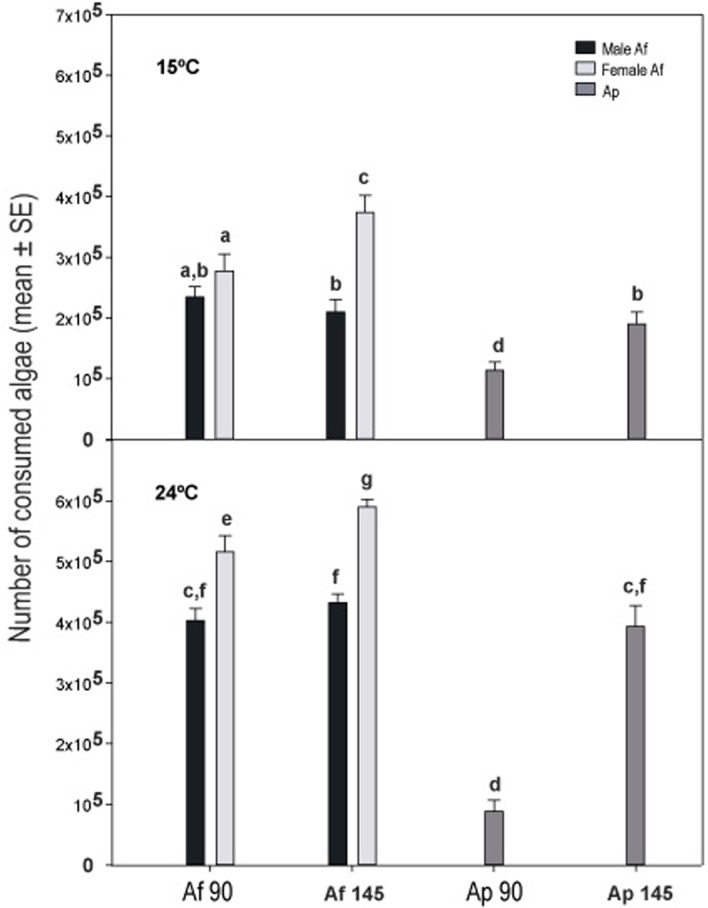
Feeding rate in Artemia.Feeding rate of unparasitized A. parthenogenetica and A. franciscana at different temperatures and salinities. Statistically significant differences among treatments are indicated by letters above the bars (according to post hoc LSD tests). When treatments do not share a letter it indicates they are significantly different. Exact P values are shown in S2 and S3 Tables.